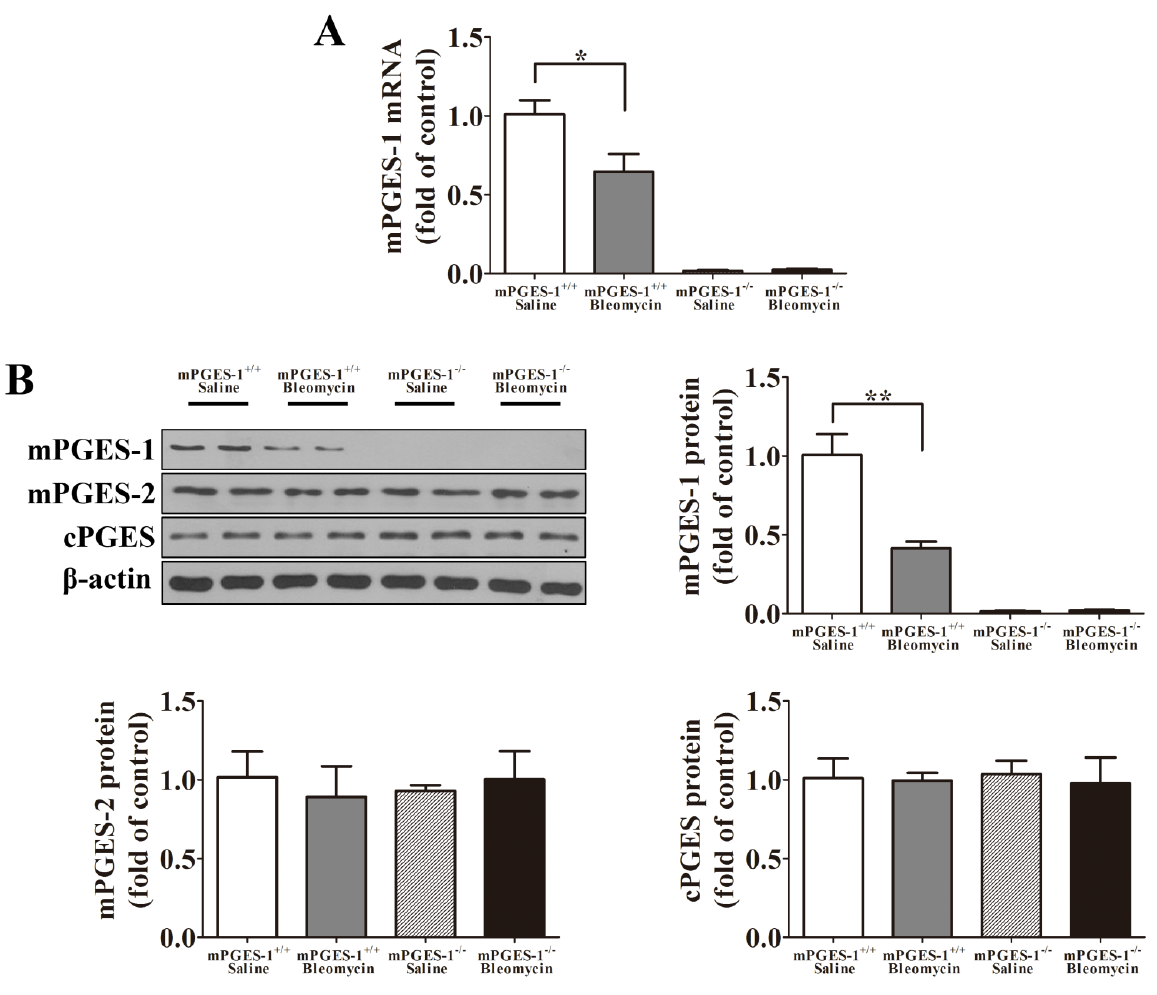
Figure 2. The mRNA and protein levels of mPGES-1, mPGES-2 and cPGES in addition to PGE content in the lungs of mice on day 28 after instillation. ( A ) Statistical chart of 2 mPGES-1 mRNA expression; ( B ) Representative western blot images and scanning densitometry of mPGES-1, mPGES-2 and cPGES protein expression; ( C ) The PGE content in the lungs of mPGES-1 +/+ mice and mPGES-1 − / − mice receiving bleomycin